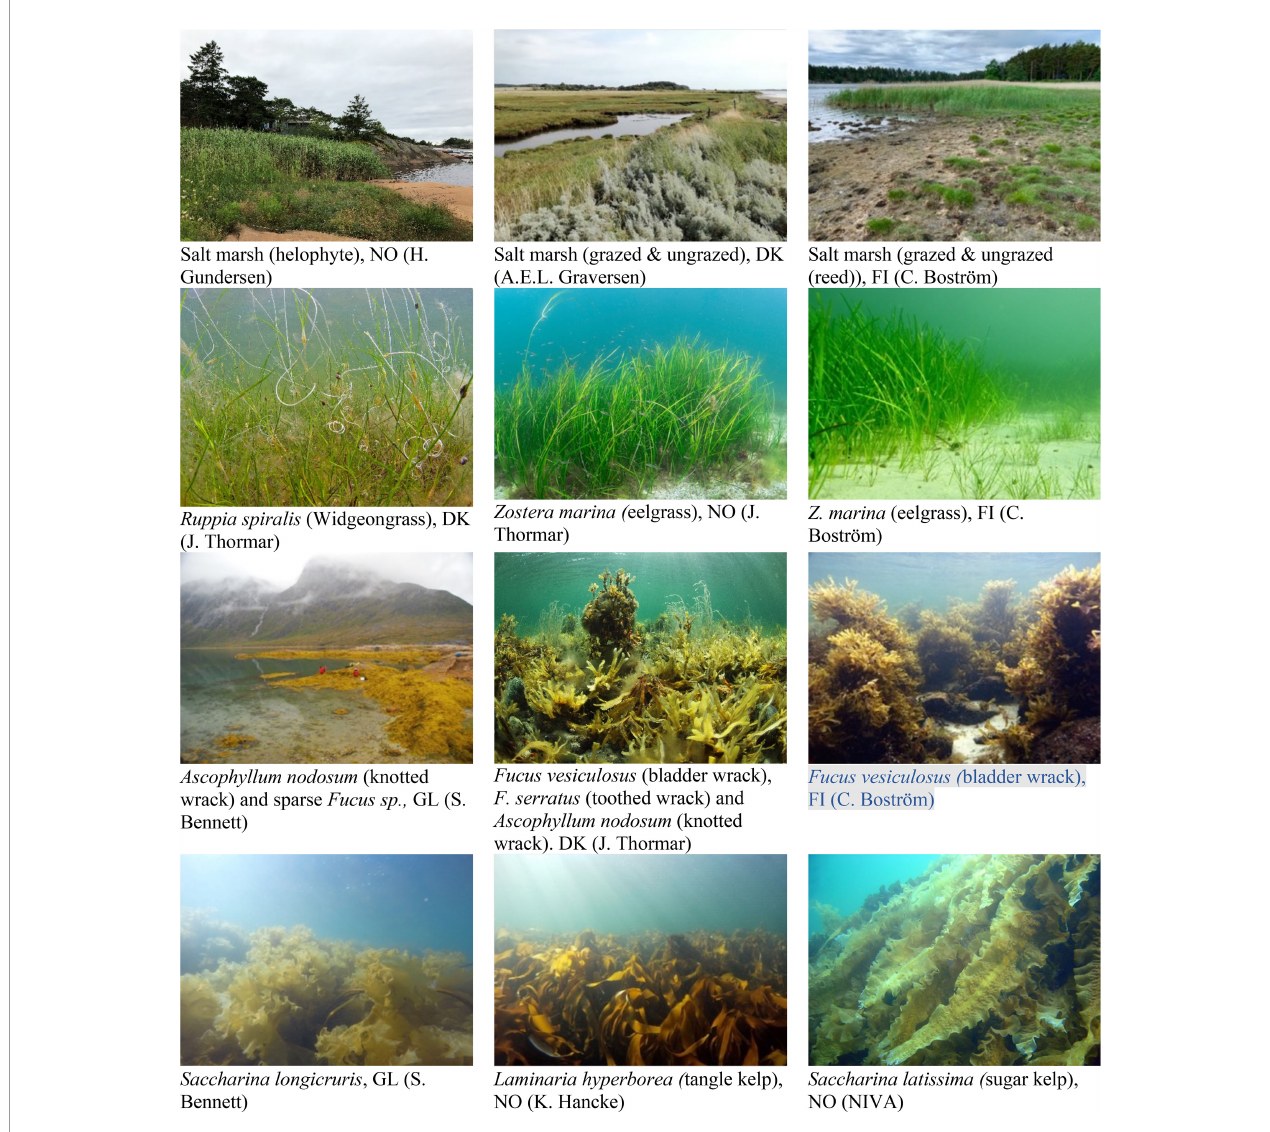
FIGURE 1 | Examples of characteristic Nordic BC habitats: Salt marsh (1 st panel), rooted vegetation such as seagrass (2 nd panel), intertidal macroalgae (3 rd panel), and submerged macroalgae, such as kelp forests (4 th panel).